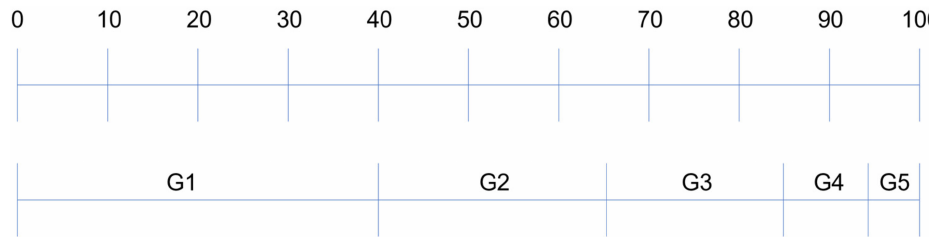
Figure 7. Range of de-identification depending on the risk level.